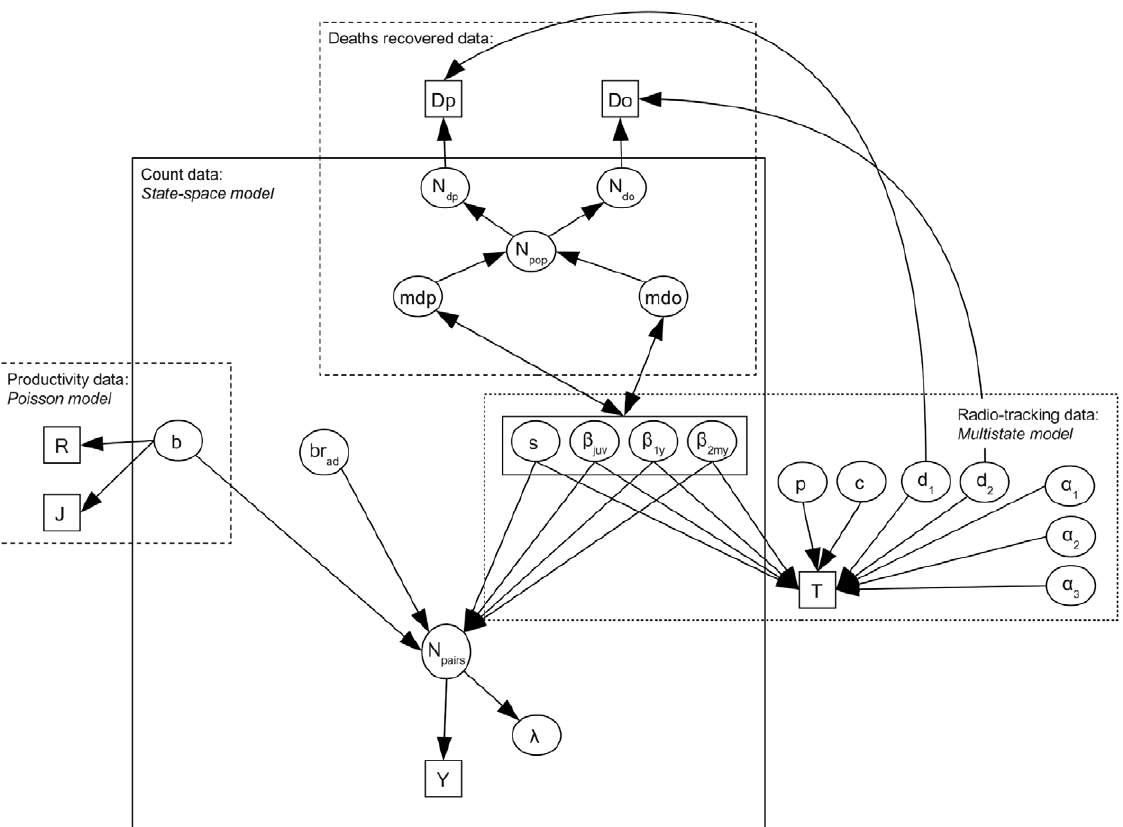
Figure 6. Graphical representation of the integrated population model. Data are symbolized by small rectangles, parameters by ellipses, the relationships between them by arrows and sub-models by open rectangles. Notation: J : annual number of fledglings; R : numbers of surveyed broods whose final fledging success was known; Dp : number of unmarked birds found dead by poisoning; Do : number of unmarked birds found dead by causes other than poisoning; T : radio-tracking data; Y : population count data; b : fecundity; mdp : average probability, across age groups, of dying because of poisoning; mdo : average probability, across age groups, of dying because of other causes; N pop : total number of individuals in the population; N dp : expected number of unmarked birds found dead by poisoning; N do : expected number of unmarked birds found dead by causes other than poisoning; s : survival probability; b juv : probability of death due to poisoning given that an animal died in its first year of life; b 1 y : probability of death due to poisoning given that an animal died in its second year of life; b 2 my : probability of death due to poisoning given that an animal died after its second year of life; p : recapture probability of an animal with a functioning radio; c : recapture probability of a radio-tagged animal which is alive but without an active radio signal; d 1 : probability of encounter of a radio-tagged animal dead by poisoning but without an active radio signal; d 2 : probability of encounter of a radio-tagged animal dead by other causes and without an active radio signal; a 1 , a 2 , a 3 : radio signal retention probability during the first three, the fourth and the fifth or more year of life, respectively; br ad : proportion of breeding females relative to the total number of females older than 2 years; N pairs : number of breeding females in the population; l : population growth rate. Priors are excluded from this graph to increase